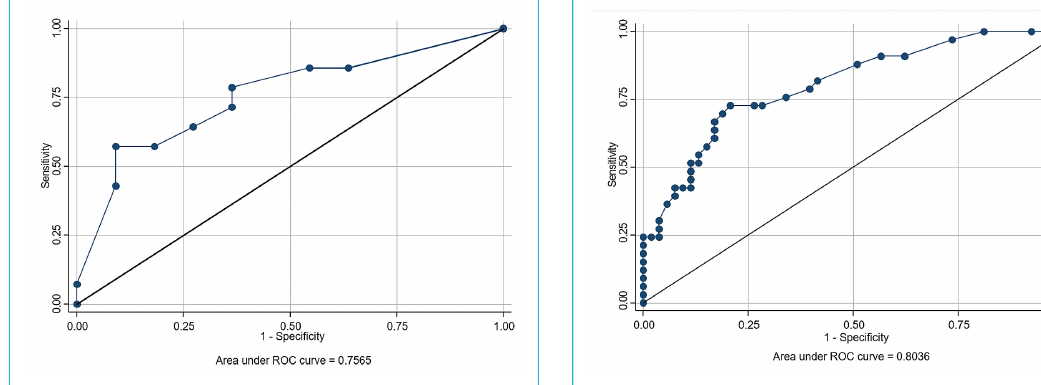
Figure 2: Receiver operating characteristic (ROC) curve of FiO 2 in patients with O 2 -supply as strong predictor of the composite out- come (ICU admission and/or mortality) with an area under the curve (AUC) of 0.76 (95% CI 0.56–0.95).